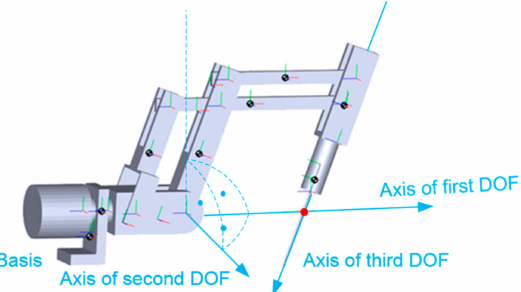
Figure 12. Model of a surgical robot with remote center of motion (RCM) made in the Simulink environment. The joint coordinate systems and the centers of gravity of the links are illustrated. The three axes necessary for obtaining a complex spherical and translational motion are marked. Such movement provides the functionality required during the operation.